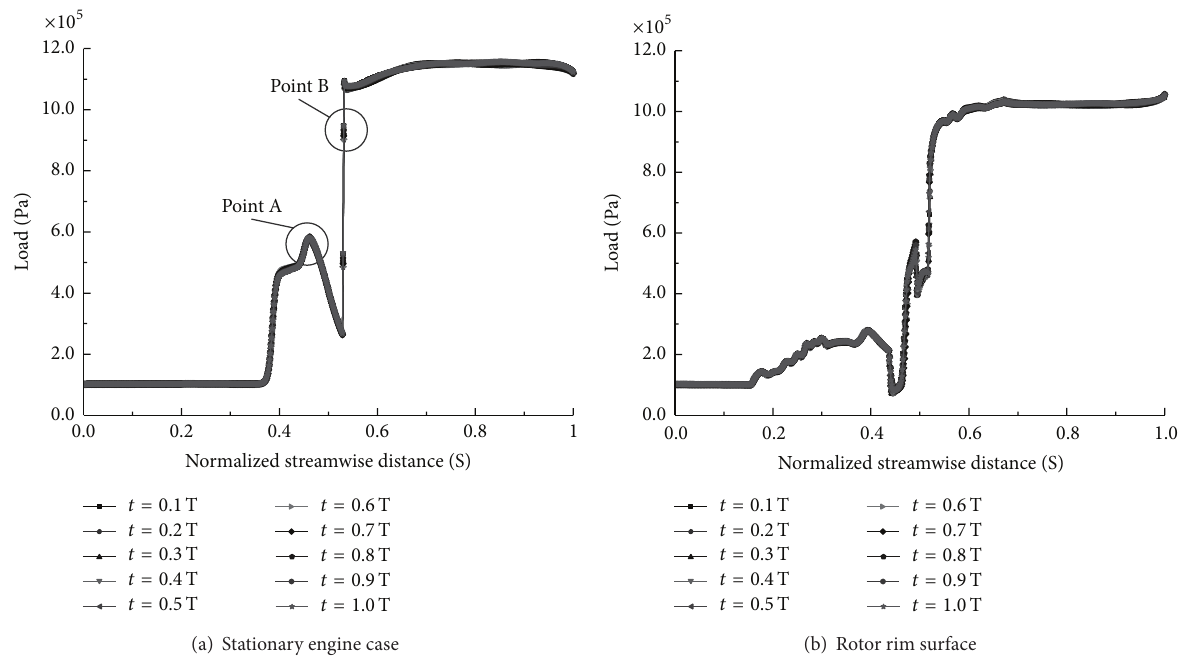
Figure 13: Pressure distributions along stationary engine case and rotor rim surface in a whirling motion cycle.